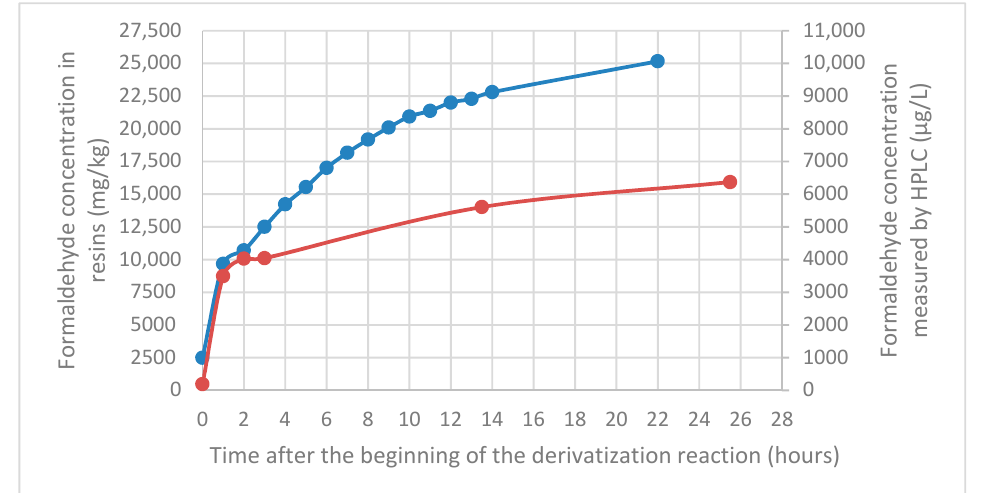
Figure 2. Formaldehyde content in dicyandiamide resin (in blue) and in melamine resin (in red) over the time. Resins (0.04 g) prepared, extracted (50 mL of 0.1% dodecane-1-sulfonic-acid aqueous solution) and derivatized following standard conditions used for leather (EN ISO 17226-1) and analyzed at various time.